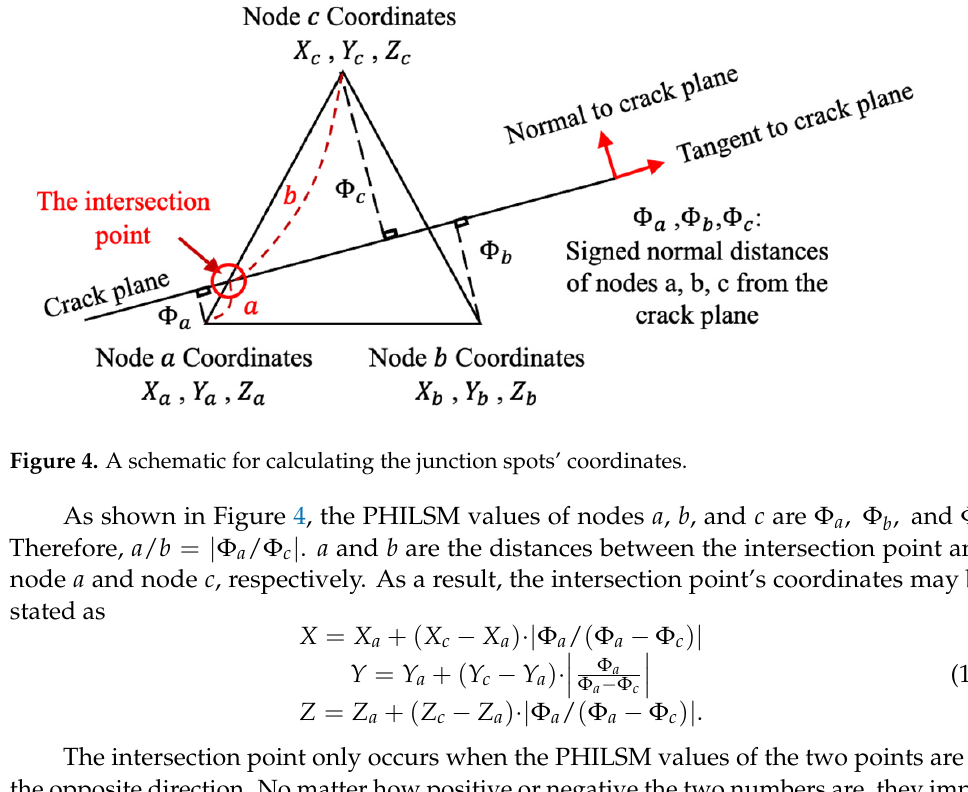
Figure 4 provide an introduction to computing the coordinates of the intersection point.